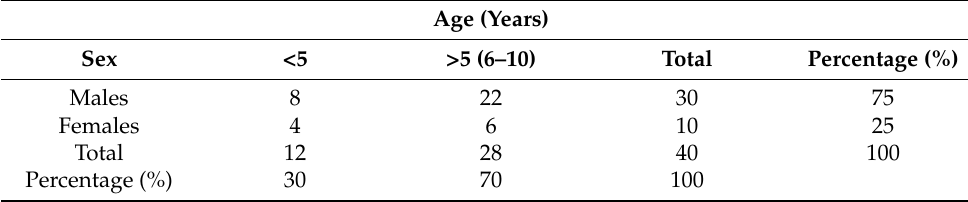
Table 4. Age and sex distribution of forty patients with dermatophytes